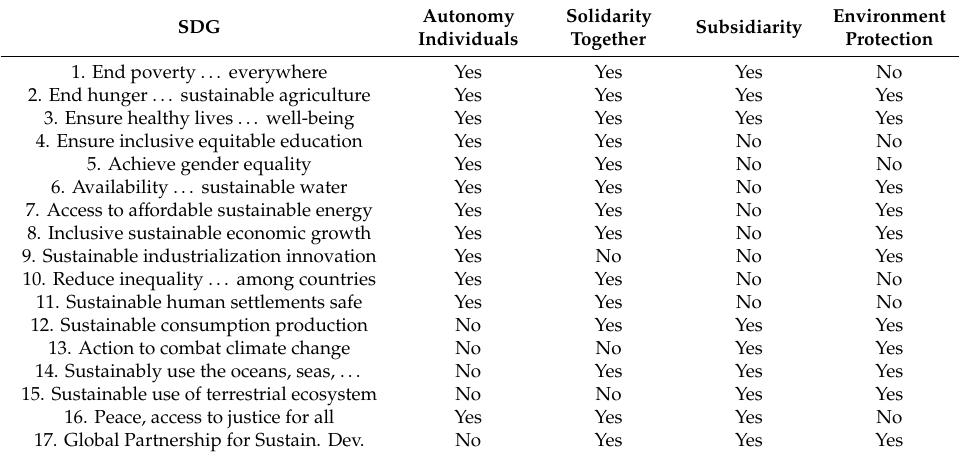
Table 4. Theory—the overlap of 17 SDGs with 4 pivotal principles of codes of ethics. SDG